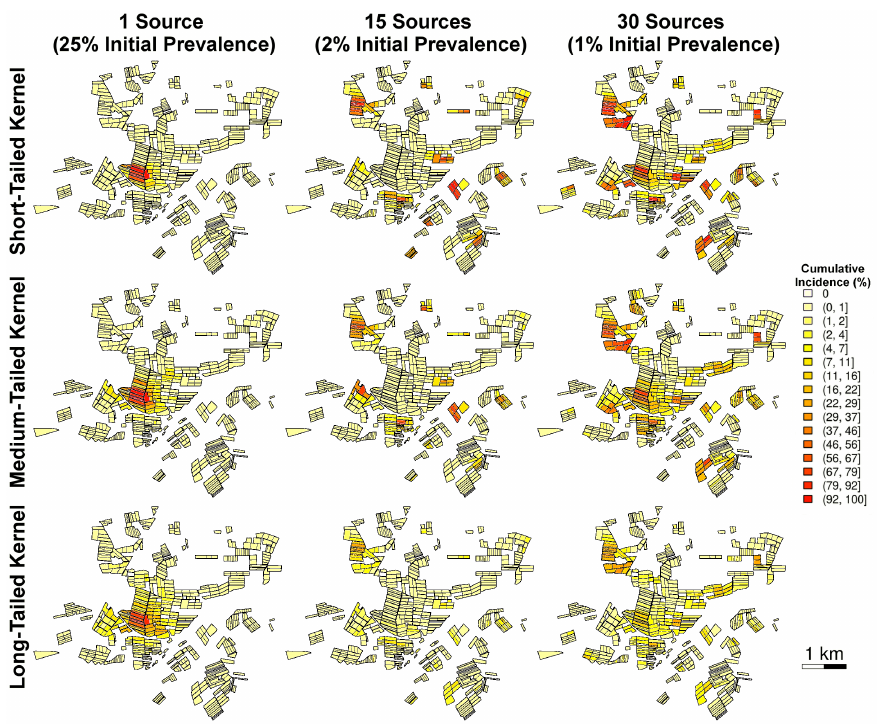
Fig 2. Cumulative detected incidence at the end of year 22 for nine simulated epidemics. Each polygon represents one peach orchard. From left to right, the number of introduction patches (with initial disease prevalence) are: 1 (25%), 15 (2%) and 30 (1%). From top to bottom: simulations generated under short-, medium- and long-range kernel